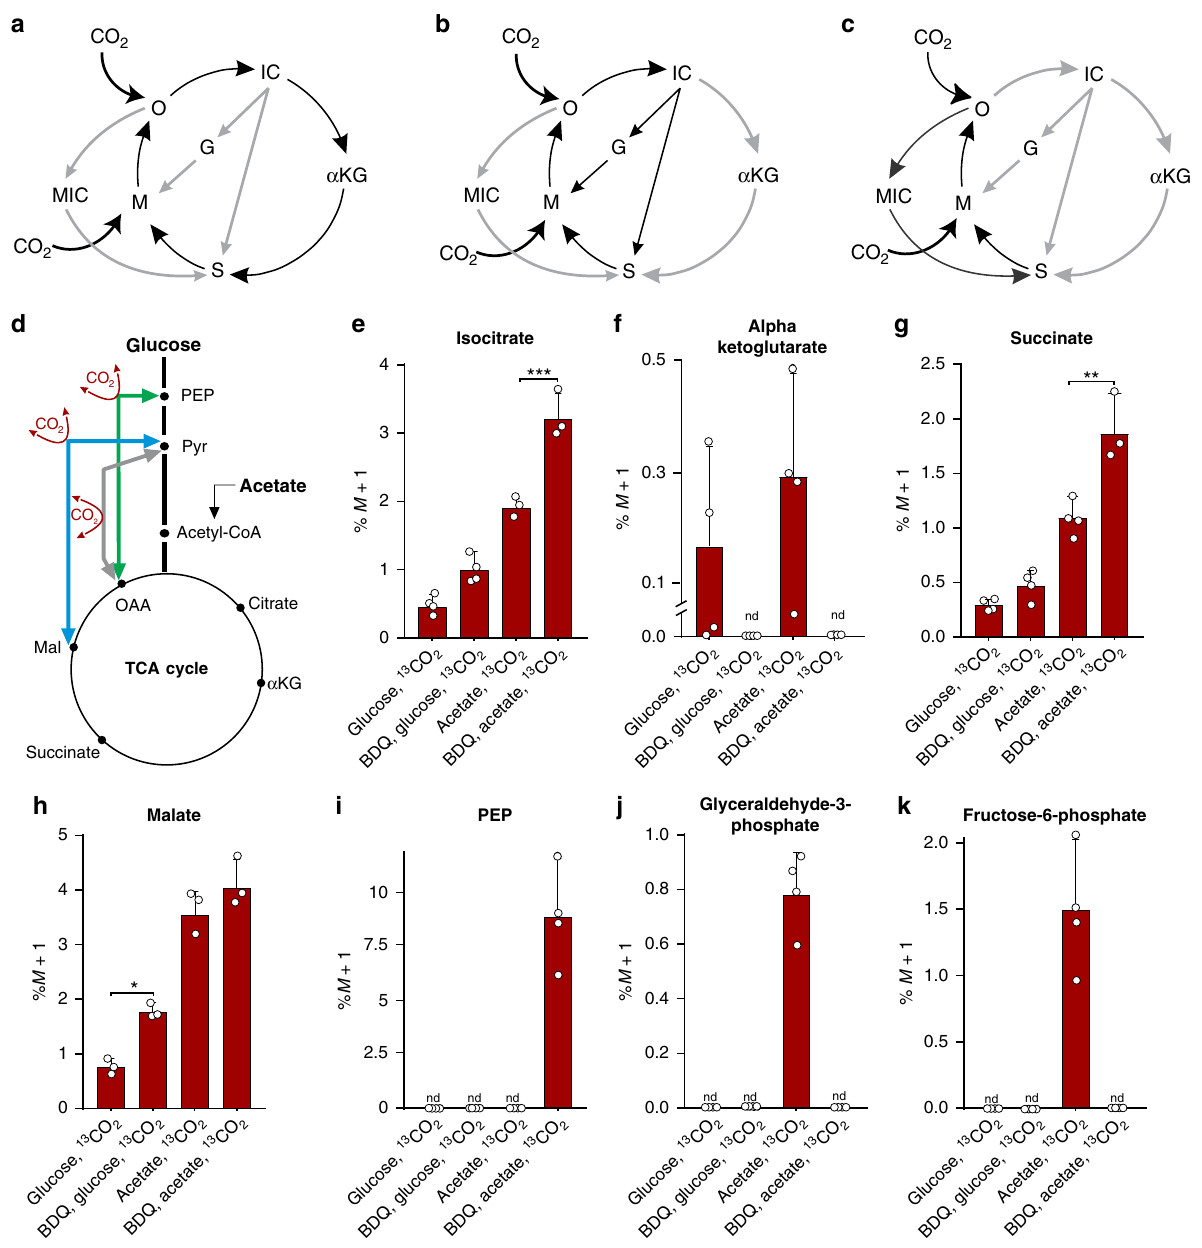
Fig. 3 BDQ exposure induces the TCA cycle to progress via the glyoxylate shunt. a The TCA cycle can progress via the oxidative branch, ( b ) the glyoxylate shunt or ( c ) via the MCC. d To investigate the effect of BDQ on gluconeogenesis and the catalytic direction of PEPCK, we cultured Mtb cells in the presence of glucose or acetate and 13 CO 2 (labelled NaH 13 CO 3 ) as the tracer. Notably, there is more labelled ( e ) isocitrate (IC), ( g ) succinate and ( h ) malate and less ( f ) α KG. However, ( i ) phosphoenolpyruvate (PEP) levels increase following BDQ treatment in acetate conditions, with ( j ) no M + 1 glyceraldehyde-3-phosphate (G3P) or ( k ) fructose-6-phosphate (F6P) being detected after BDQ treatment (under acetate conditions). Mean + / − standard error of the mean (SEM) of at least three replicate extracts is indicated. One representative experiment is shown, with the experiment being repeated a minimum of two times. A two-way ANOVA and a Tukey multiple-comparison test were used for the statistical analysis. n = 4 biologically independent samples. * P < 0.05, ** P < 0.01, *** P < 0.001. BDQ - bedaquiline, nd - not